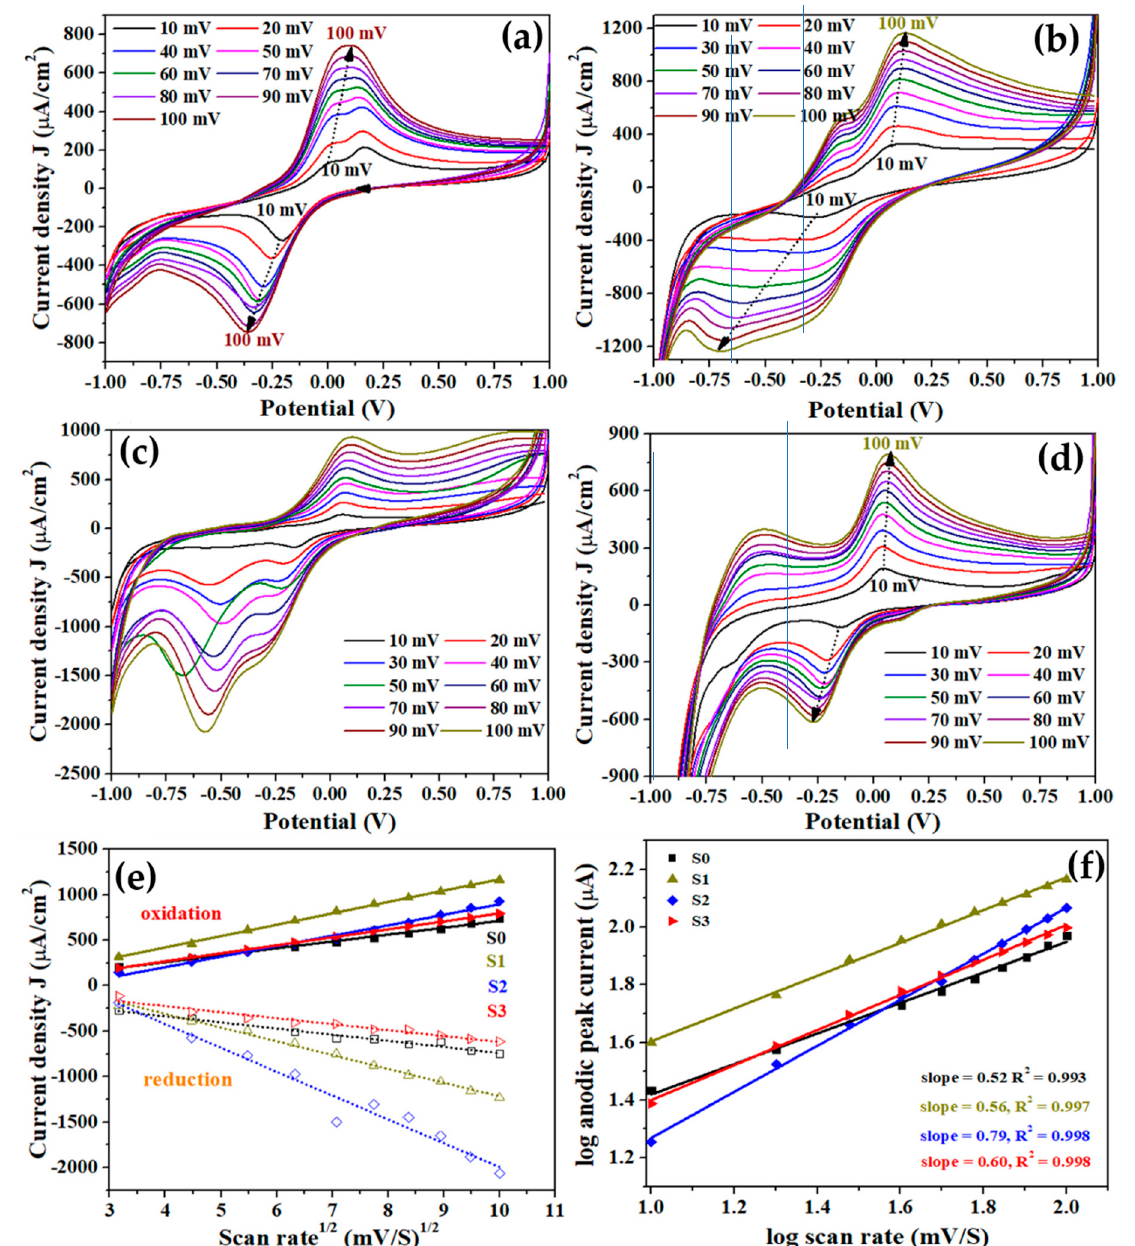
Figure 6. CV curves for pure ( a ) and ( b – d ) Cu-doped TiO 2 nanomaterials at various scan rates (10 to 100 mV/s) in the presence of 7nM Mb; ( e ) plot of redox peak current against square root of scan rate, and ( f ) plot of log of oxidation peak current against log of scan rate. Experimental data points are represented by symbols and dotted line indicates best fit.